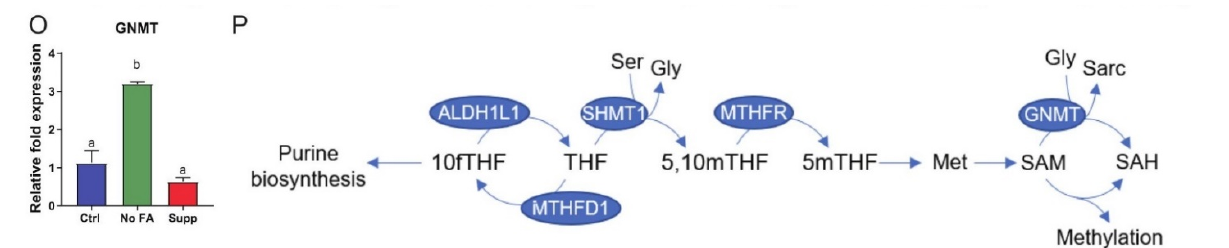
Figure 2. Dietary FA modulates tumor one-carbon metabolism. Comparison of one-carbon pathway metabolites in MDA- MB-231 tumors from control (Ctrl, 2 ppm FA), FA-deficient (No FA, 0 ppm FA), or FA-supplemented (Supp, 12 ppm FA) diets (n = 6 samples/group) ( A – H ). Relative abundance of 5mTHF ( A ), PRPP ( B ), SAICAR ( C ), AICAR ( D ), serine ( E ), SAM ( F ), methionine ( G ), sarcosine ( H ). Expression of MTHFD1 ( I ), MTHFR ( J ), ALDH1L1 ( K ), ALDH1L2 ( L ), SHMT1 ( M ), SHMT2 ( N ), and GNMT ( O ) measured by qPCR in tumors from each diet group (n = 5/group). Pathway of cytosolic folate enzymes evaluated in this study ( P ). One-way ANOVA used to determine statistical significance ( p < 0.05), different letters indicate significant differences.